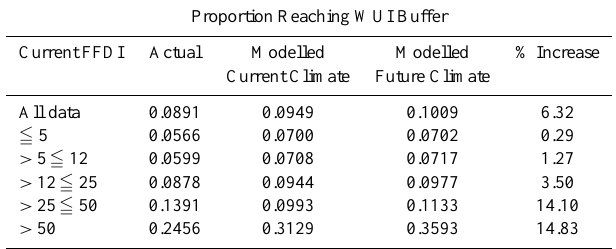
Table 4. Proportions of fires reaching the WUI buffer under dif- ferent weather conditions for current and projected future climates. The column Modelled Current Climate refers to the predicted values from the preferred model and the Modelled Future Climate column used the same model, but with increased FFDI values based on the future climate